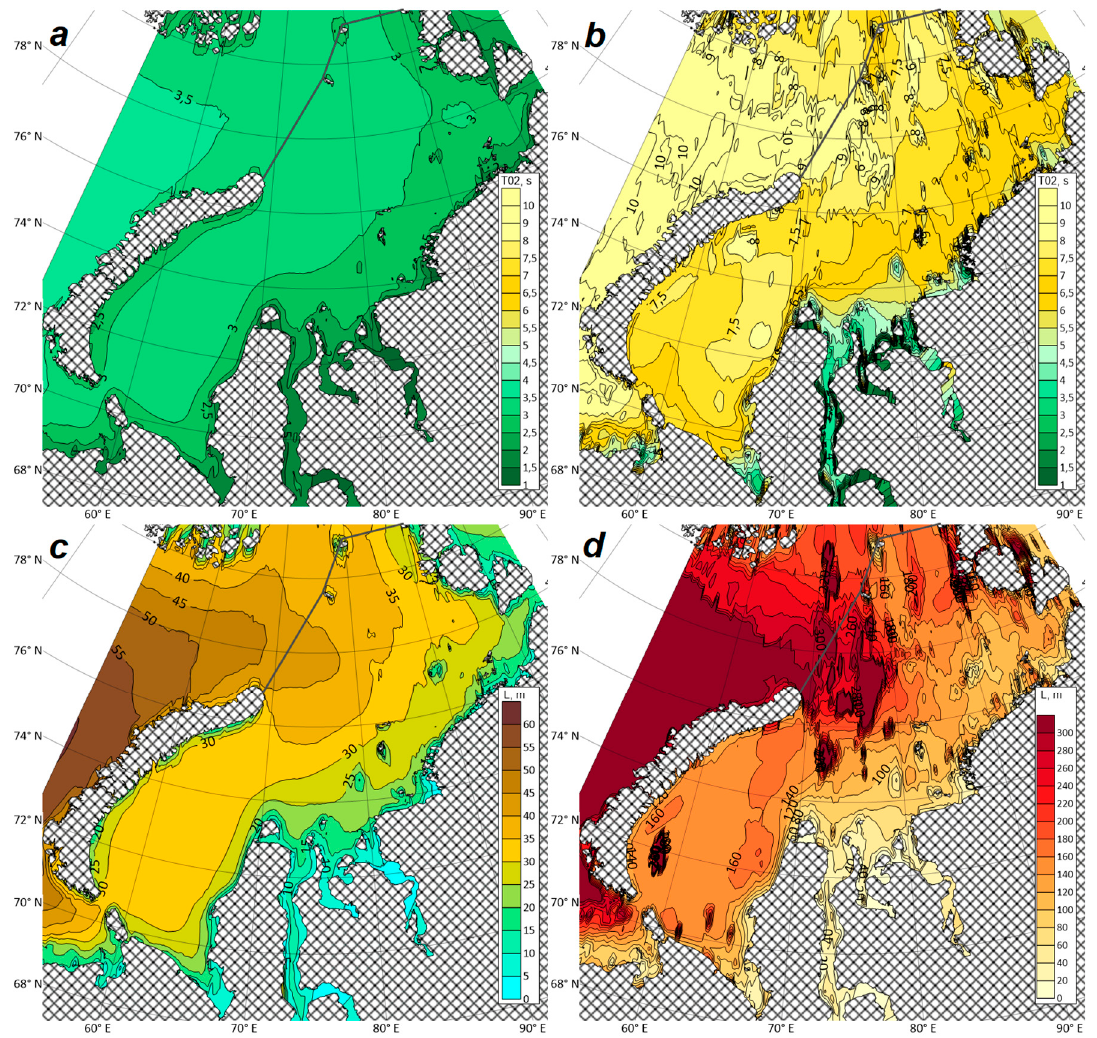
Figure 7. The long-term mean period ( a ), the maximum period ( b ), the long-term mean wavelength ( c ), and the maximum wavelength ( d ) in the Kara Sea according to modeling data for the period from 1979 to 2017.